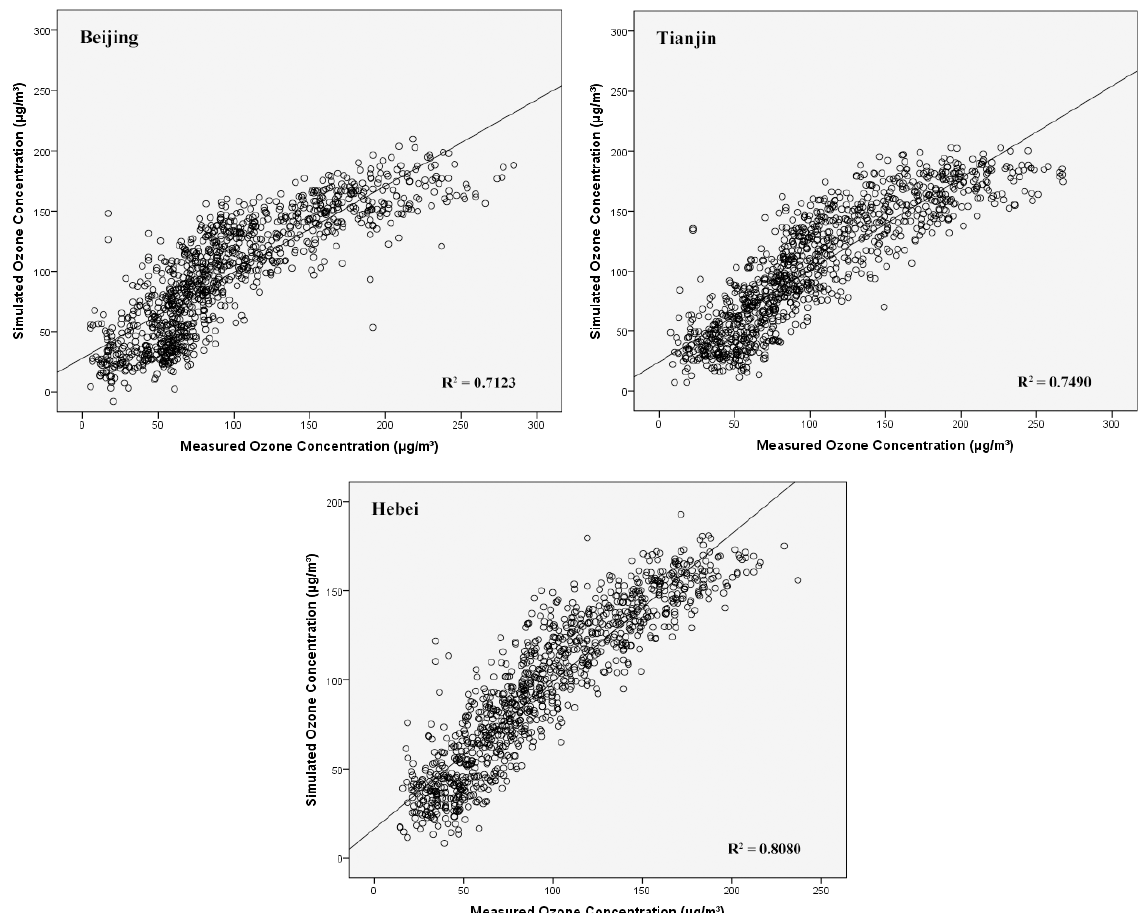
Figure 6. Relationship between the monitored and simulated concentrations of O 3 _8h based on the stepwise regression model during 2018 to 2020 in Jing-Jin-Ji region.